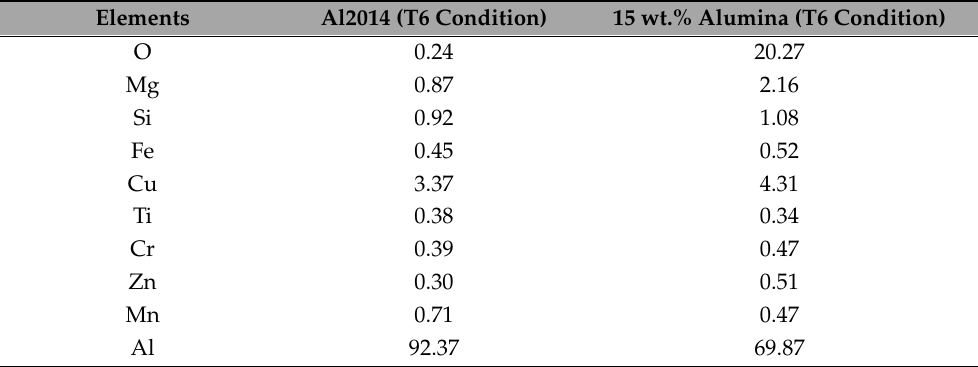
Table 3. Composition of Al2014 and Al2014-Al 2 O 3 composites in wt.% by EDS analysis at heat- treated condition.